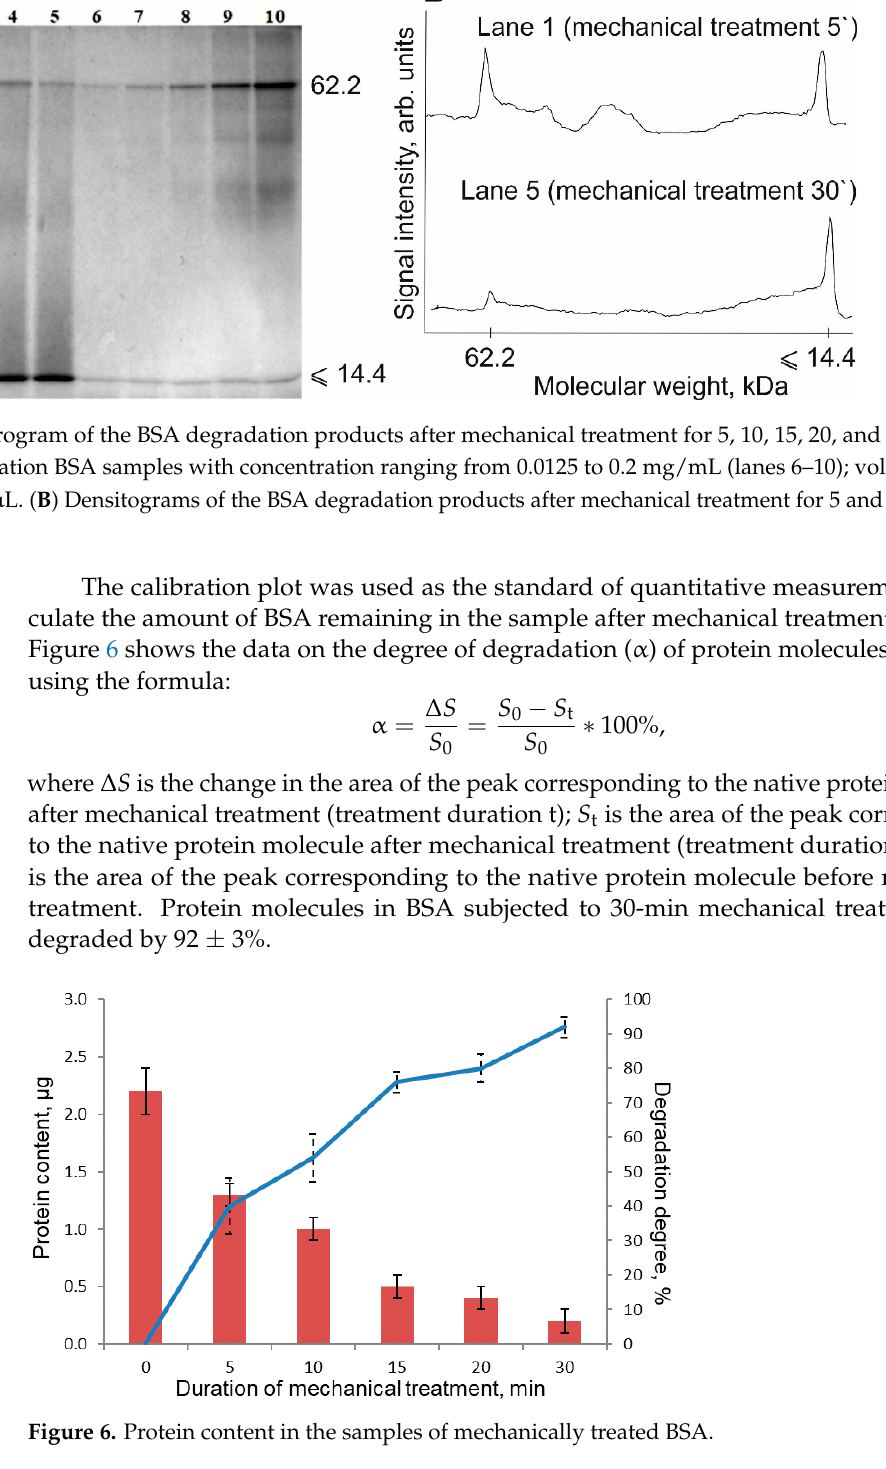
Figure 4. The calibration plot for BSA quantification.